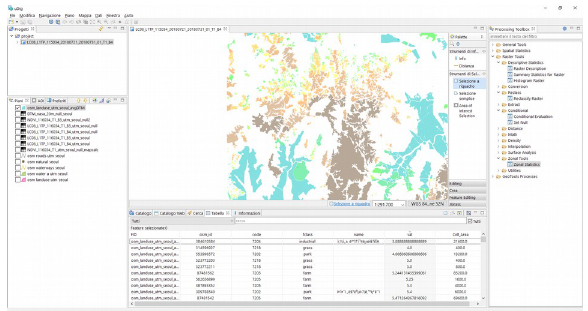
Figure 7. Operations on raster data: ZonalStats, the selection and output of the